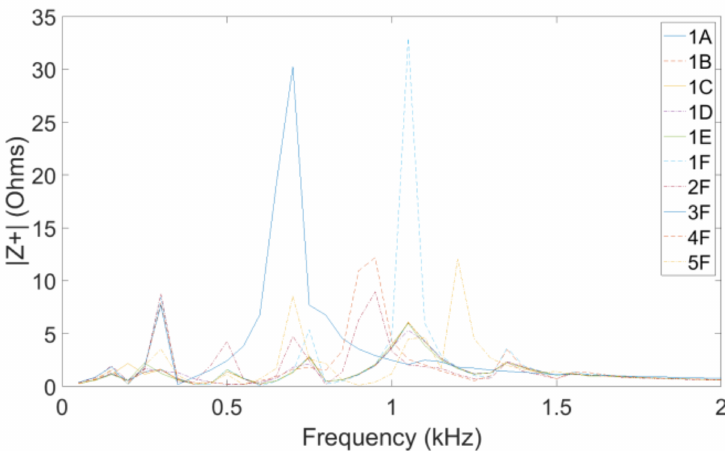
Figure A4. Public grid impedance scenarios: public grid impedance versus frequency.